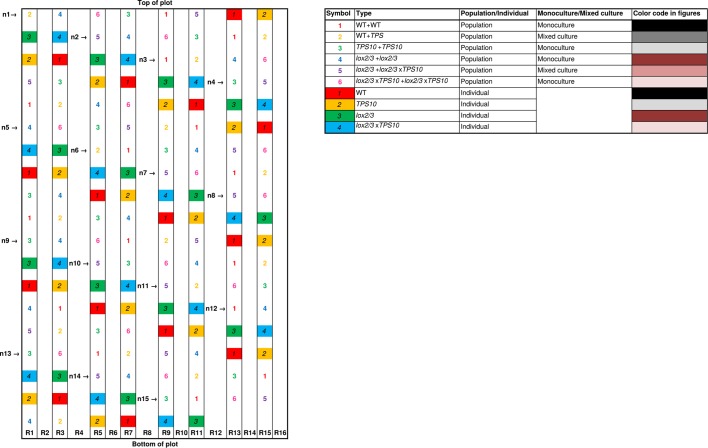
Layout in experimental season two, and color codes.R, row of earth between two irrigation lines; not to scale.